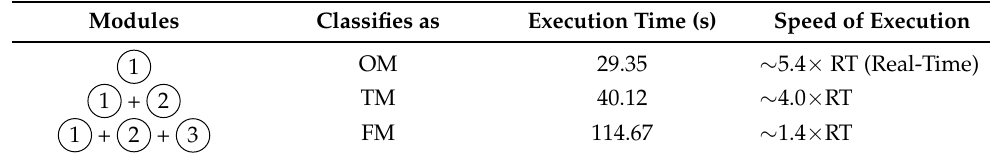
Table 1. Result of simulation performance